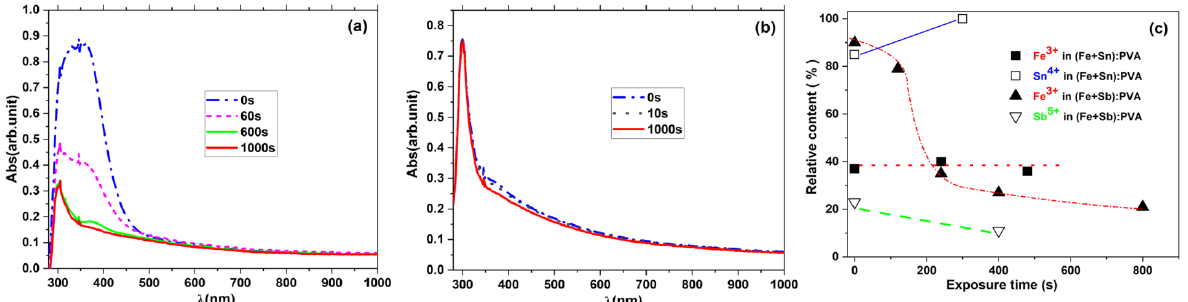
Figure 5. Optical absorption spectra of ( a ) (FeCl 3 (2.5%) + SbCl 3 (2.5%)): PVA (10%); ( b ) (FeCl 3 (2.5%) + SnCl 2 (2.5%)): PVA (10%) samples after different UV exposures, and ( c ) the variation of the relative fraction of metallic ions in the highest oxidation state in the corresponding samples.